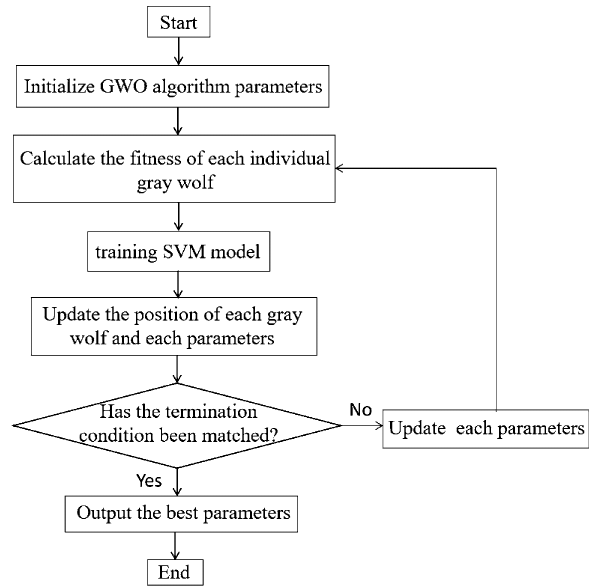
Figure 3. Flowchart of SVM optimized by GWO